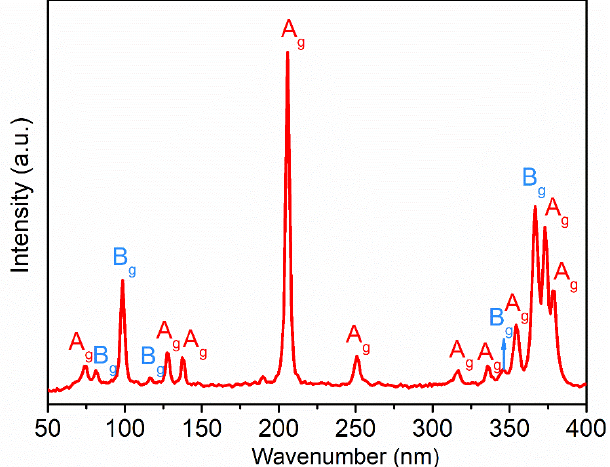
Figure 4. Raman spectrum of GeP crystal marked with A g and B g Raman modes.